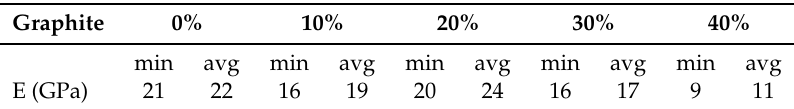
Table 3. Young’s modulus (E) of